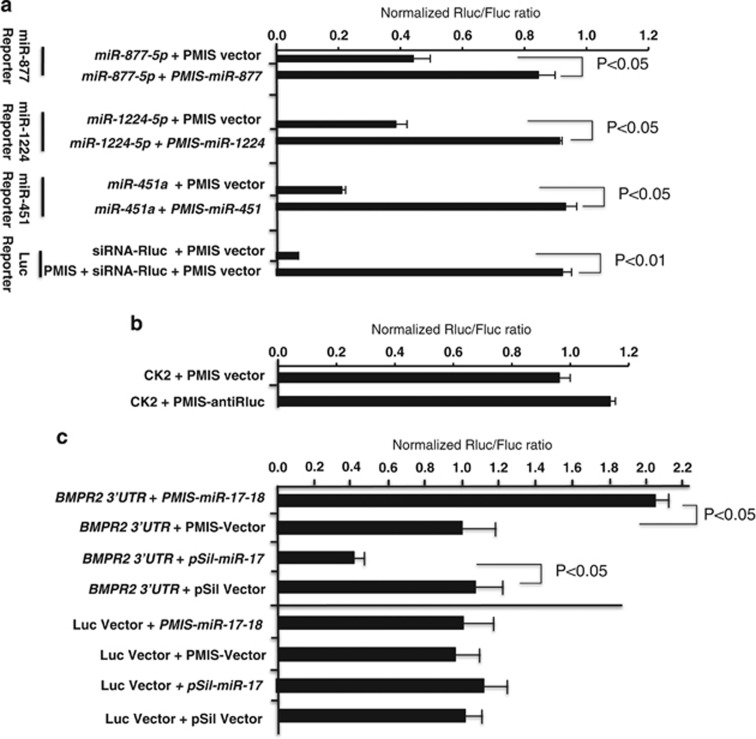
Efficiency of PMIS-miR inhibitor targeting noncanonical miRs. (a) Efficiency of PMIS-miR inhibitors targeting intronic miRs that bypass Drosha processing miR-877-5p and miR-1224-5p, Dicer-independent miR-451a and in vitro transcribed siRNA. PMIS-miR inhibitor targeting Rluc mRNA served as a control. Rluc and Fluc were assayed as in previous figures. (b) As an additional control, PMIS-anti-Rluc had no effect on luciferase expression and activity. (c) The BMPR2 3′UTR was cloned into the luciferase vector and co-transfected with PMIS-miR-17-18, vector only or pSil-miR-17 (overexpression) in 293 cells.